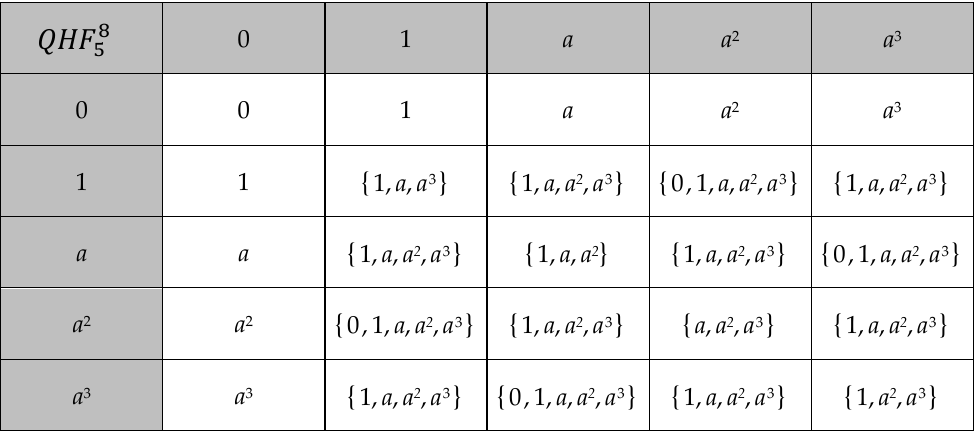
Table 20. The Cayley table of the additive canonical hypergroup of the quotient hyperfield ℤ 29 /{1,7,16,20,23,24,25}.